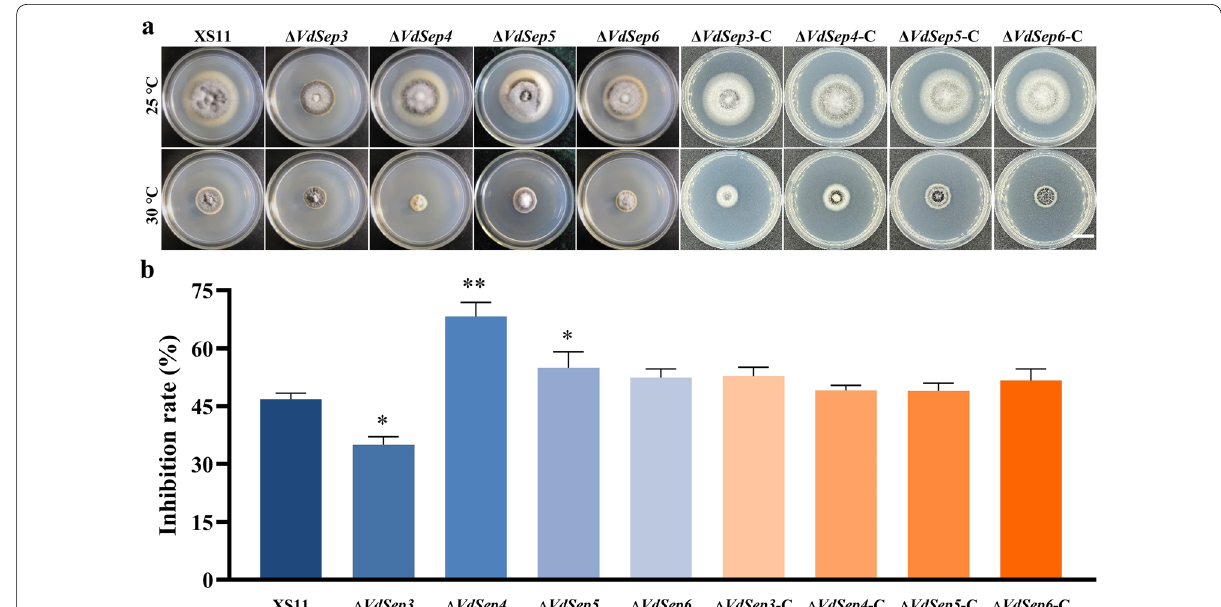
Fig. 2 Disruption of septins changes the sensitivity to high-temperature stress. a Colonies of XS11 and the mutants (Δ VdSep3 , Δ VdSep4 , Δ VdSep5 , and Δ VdSep6 ) were grown on potato dextrose agar (PDA) for 10 days at 25 °C and 30 °C. Bar inhibition rate at 30 °C. The inhibition rate (%) represent standard deviation based on three independent replicates (**, P < 0.01; *, P <